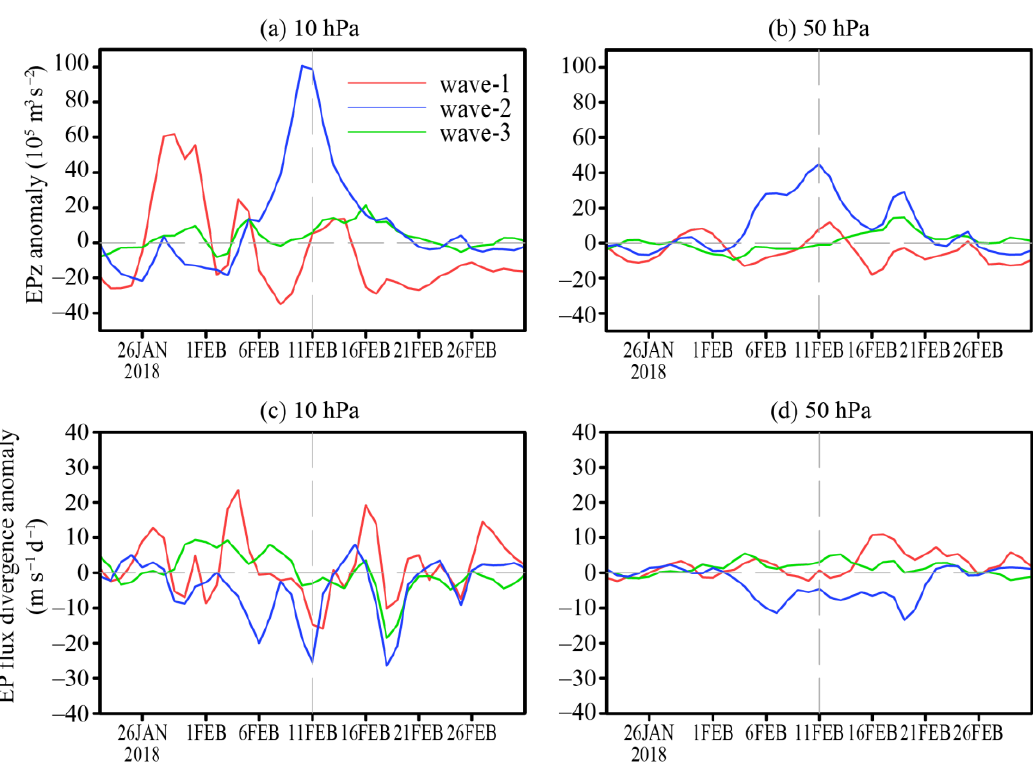
Figure 5. Temporal evolutions of ( a , b ) the vertical component of Eliassen–Palm (EP) flux anomalies and ( c , d ) the divergence anomalies of EP flux in 55–75 ◦ N at ( a , c ) 10 hPa and ( b , d ) 50 hPa, respectively by planetary wavenumber 1 (red), 2 (blue) and 3 (green).